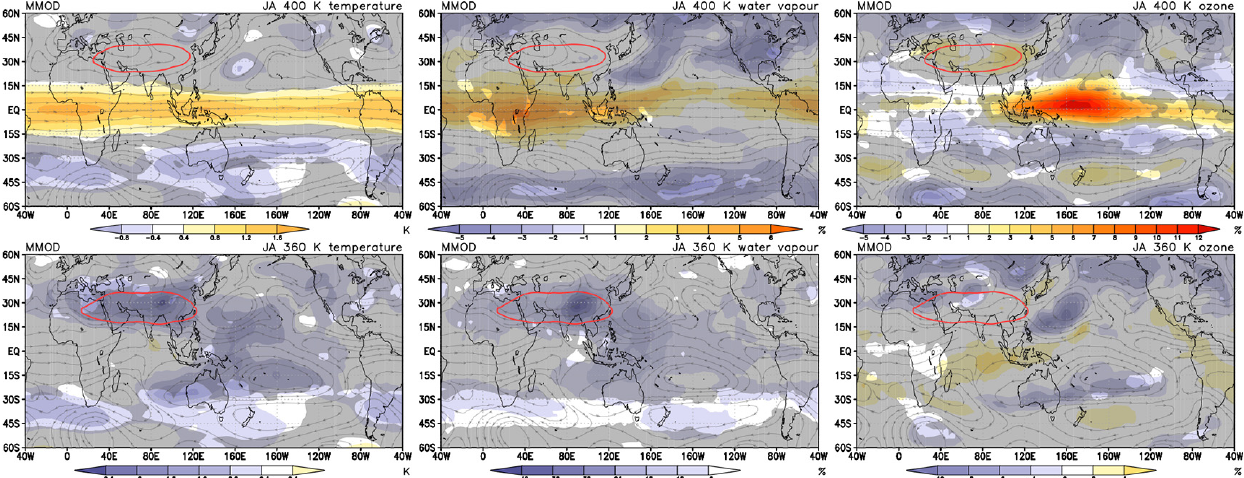
Figure 11. As Fig. 9 but for the quasi-biennial oscillation on the isentropic levels 360 and 400K (from bottom to top), including the CCMs: CCSRNIES, EMAC, EMAC-FUB, E39CA, SOCOL, UMUKCA-UCAM, and WACCM. The contour level for the 400K Montgomery stream function is 3730 × 10 2 m 2 s − 2